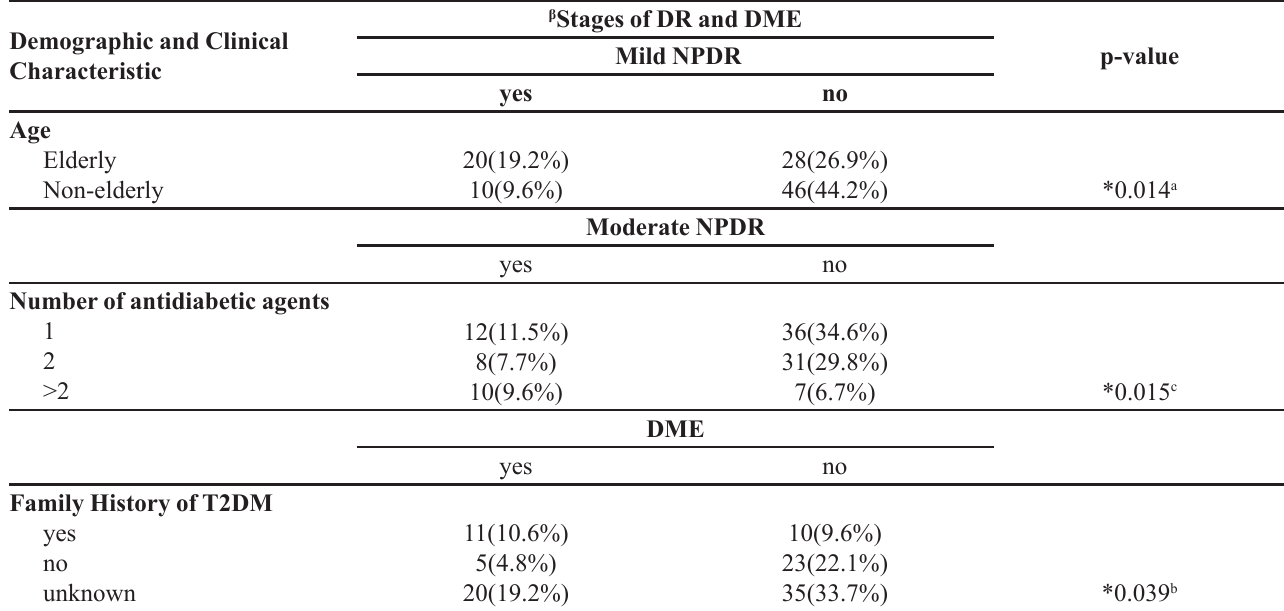
TABLE VIII - Factors of demographic and clinical characteristic that significantly associated with stages of diabetic retinopathy (DR) and diabetic macular edema